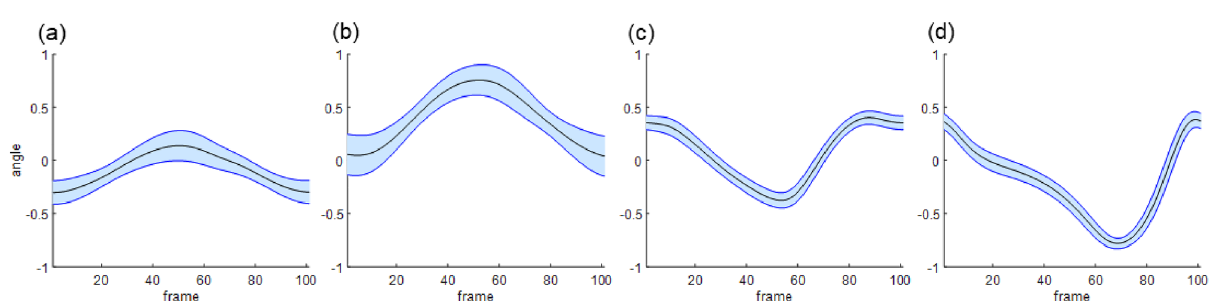
Figure 2. x-directional cosine plot of the segments. From left to right, each segment corresponds to the right upper arm (a) , right lower arm (b) , right upper leg (c) , and right lower leg (d)